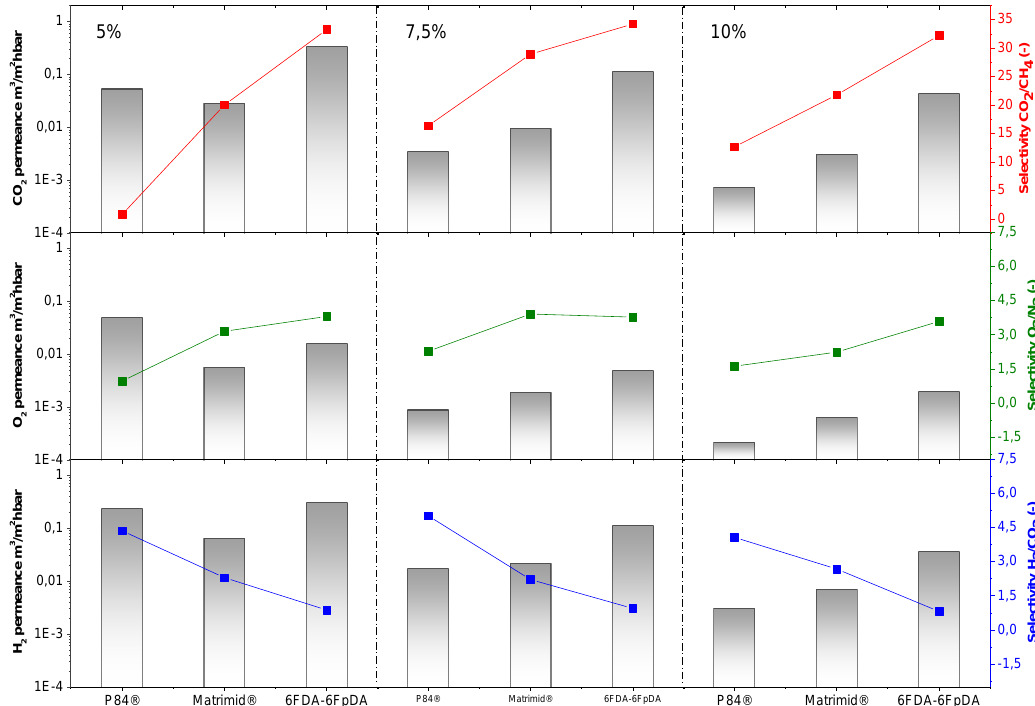
Figure 11. Evolution of the separation properties for the ceramic-supported thin film polymers obtained from 5, 7.5, and 10 wt. % solution for the gas pairs CO 2 /CH 4 , O 2 /N 2 , and H 2 /CO 2 . Permeances (left y-axis) are plotted in logarithmic scale at room temperature.